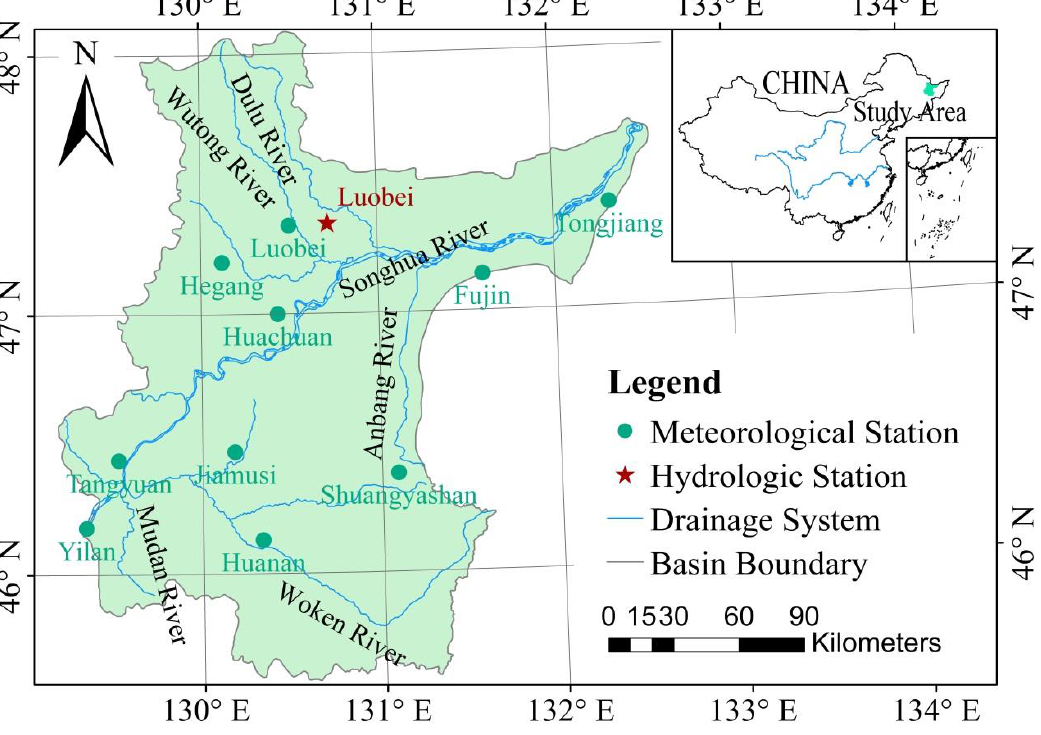
Figure 1. Schematic diagram of the study area.